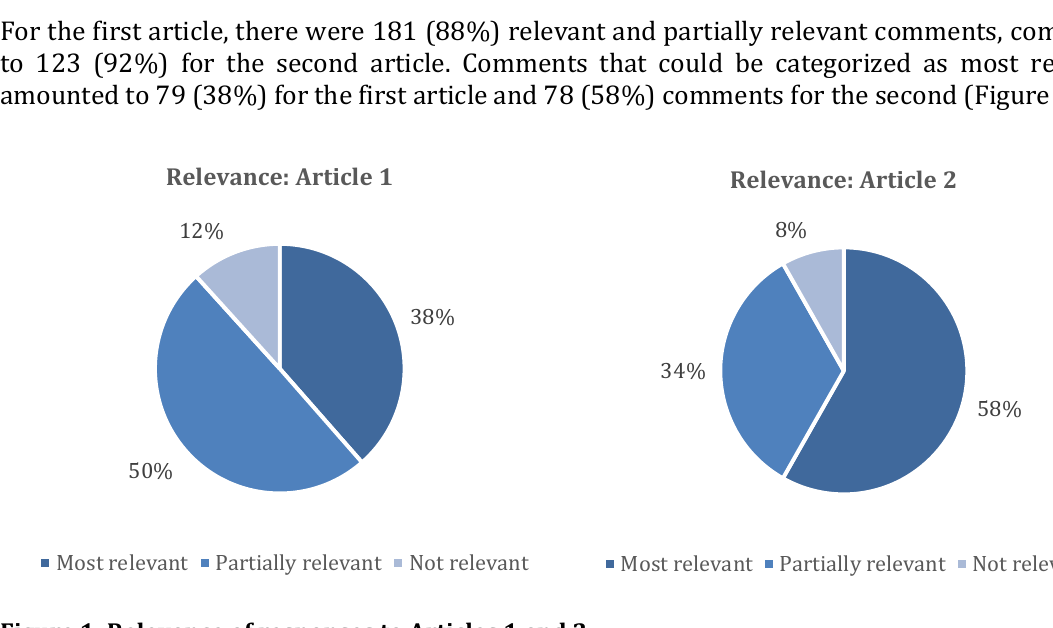
Examples of partially relevant comments